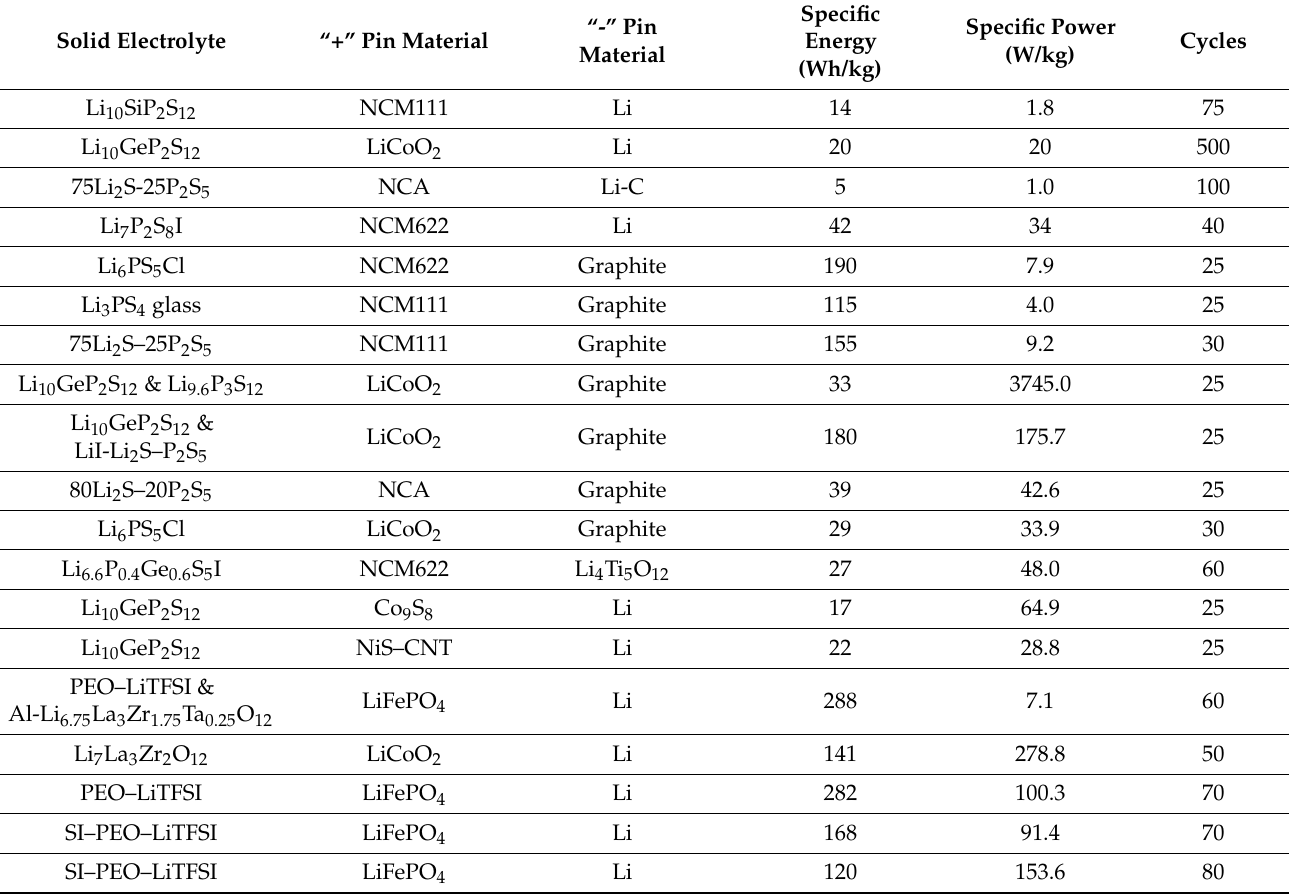
Table 5. State-solid battery main